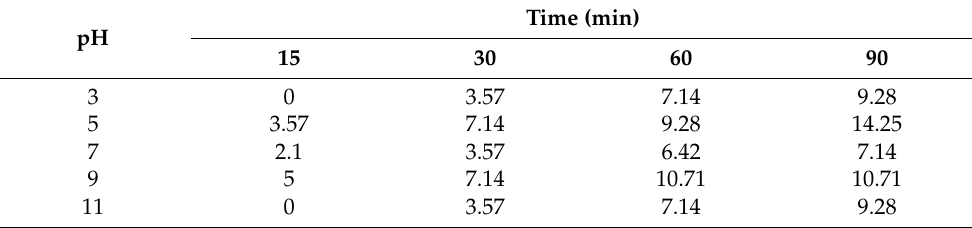
Table 5. The experimental results of the photo-Fenton process optimization for formaldehyde removal